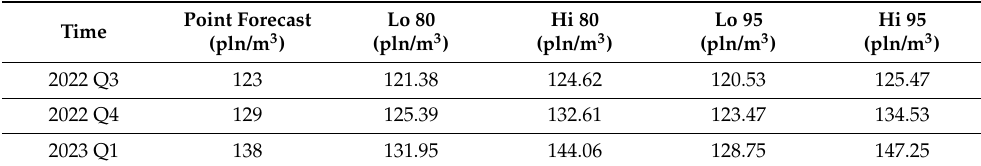
Table 4. Price forecast for the S4 assortment in Q3 of 2022, Q4 of 2022, and Q1 of 2023. Source: Own elaboration based on data obtained from the State Forests IT System (SILP).